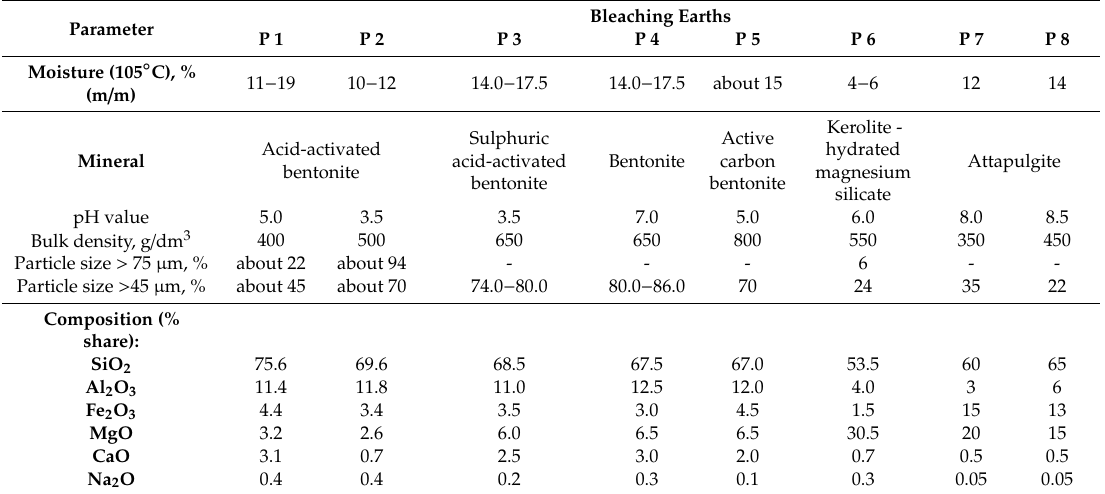
Table 1. Selected physicochemical properties of bleaching earths used in the process of oil refining. Parameter Moisture (105 ◦ C), % (m / m)